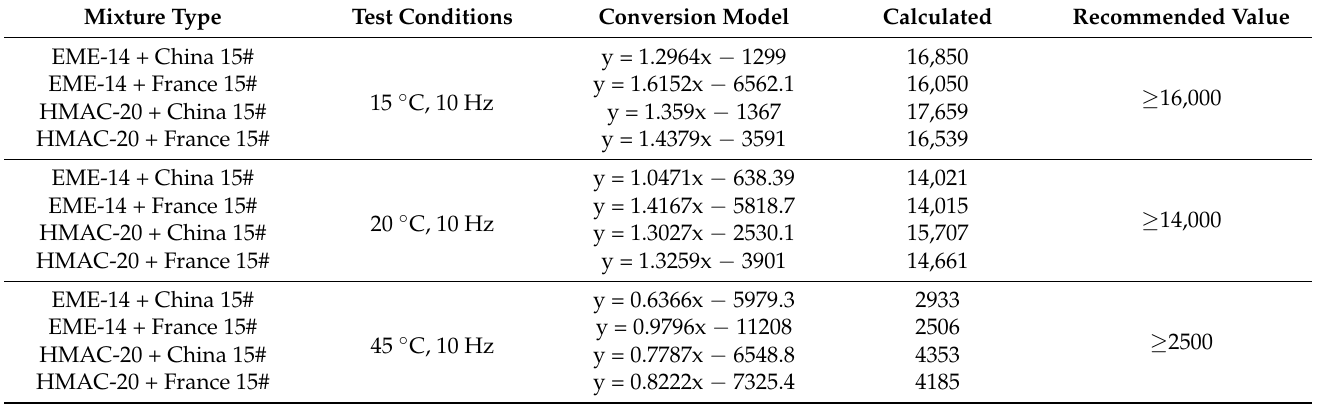
Table 11. High-modulus mixture uniaxial compression dynamic modulus evaluation index under different tempera- ture conditions.